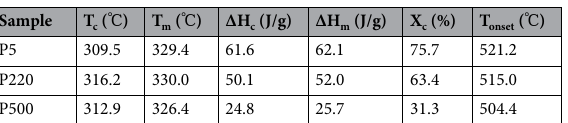
Table 1. Statistical data of DSC and TGA for three PTFE powders.